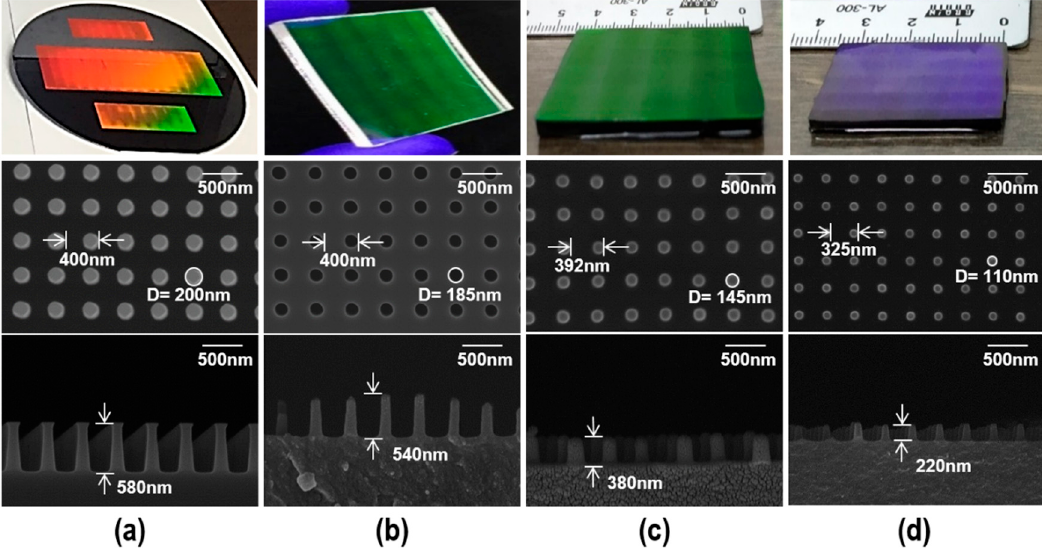
Figure 2. Images (top) and scanning electron microscope (SEM) images (middle: top-view, bottom: cross-sectional view) of the fabricated samples at each processing step; ( a ) Si master, ( b ) polydimethylsiloxane (PDMS) intermediate mold (the cross-sectional view image was obtained from the UV-imprinted sample from the PDMS intermediate mold), ( c ) Furan precursor, and ( d ) Vitreous carbon (VC) stamp.